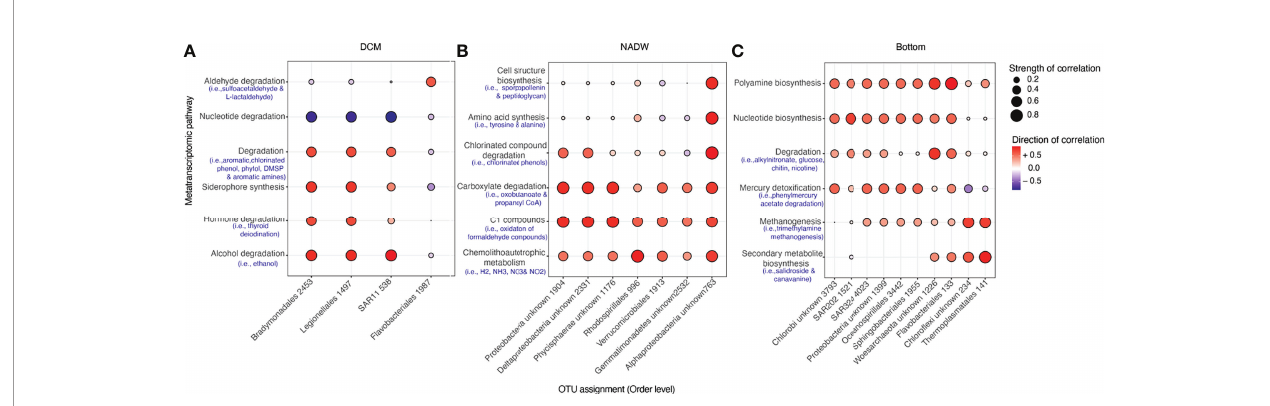
FIGURE 7 | Bubble plots delineating relationships between indicator microorganisms (IV > 95) and select metatranscriptomic pathways in the (A) DCM, (B) NADW, and (C) Bottom waters, where a darker red colour depicts a stronger positive correlation and lighter blue colours depict a stronger negative correlation between an indicator organism and a particular pathway class, and the size of the bubble depicts strength of this correlation. Blue text beneath broader functional MetaCyc groupings highlight examples of speci fi c pathways belonging to these pathway classes. All indicators are labelled according to their Order taxonomic designation along with their unique OTU ID. A cluster diagram depicting the relationships between indicator microorganisms and all metatranscriptomic pathways is shown in Supplementary Figure 3 .